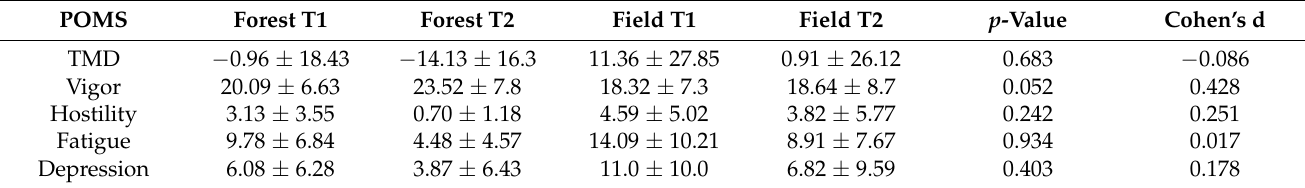
Table 3. Profile of Mood States (POMS) summer collective ( n = 23, mean ± SD). TMD = Total Mood Disturbance.